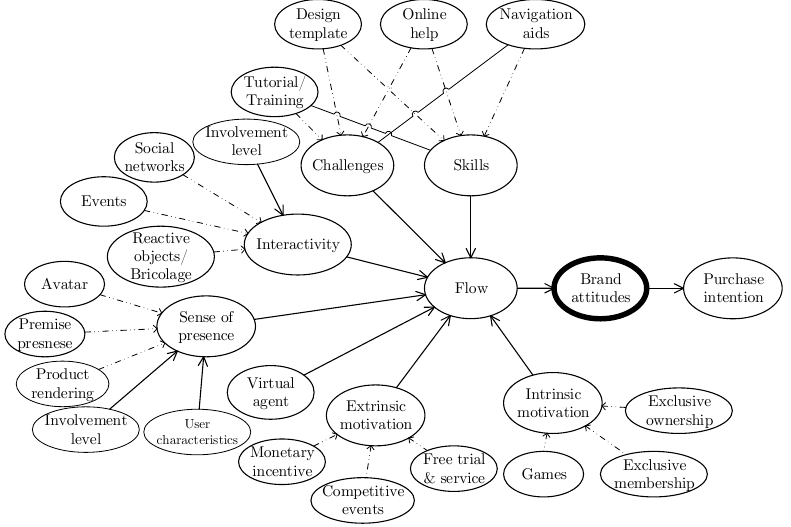
Figure 9. Conceptual framework of a consumer’s brand